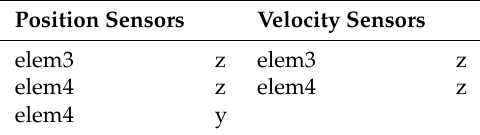
Figure 17. Estimation of the velocities of elem3 and elem4 with reference to the sensor layout in Table 3. Reference data from MBDyn. Table 3. Sensors